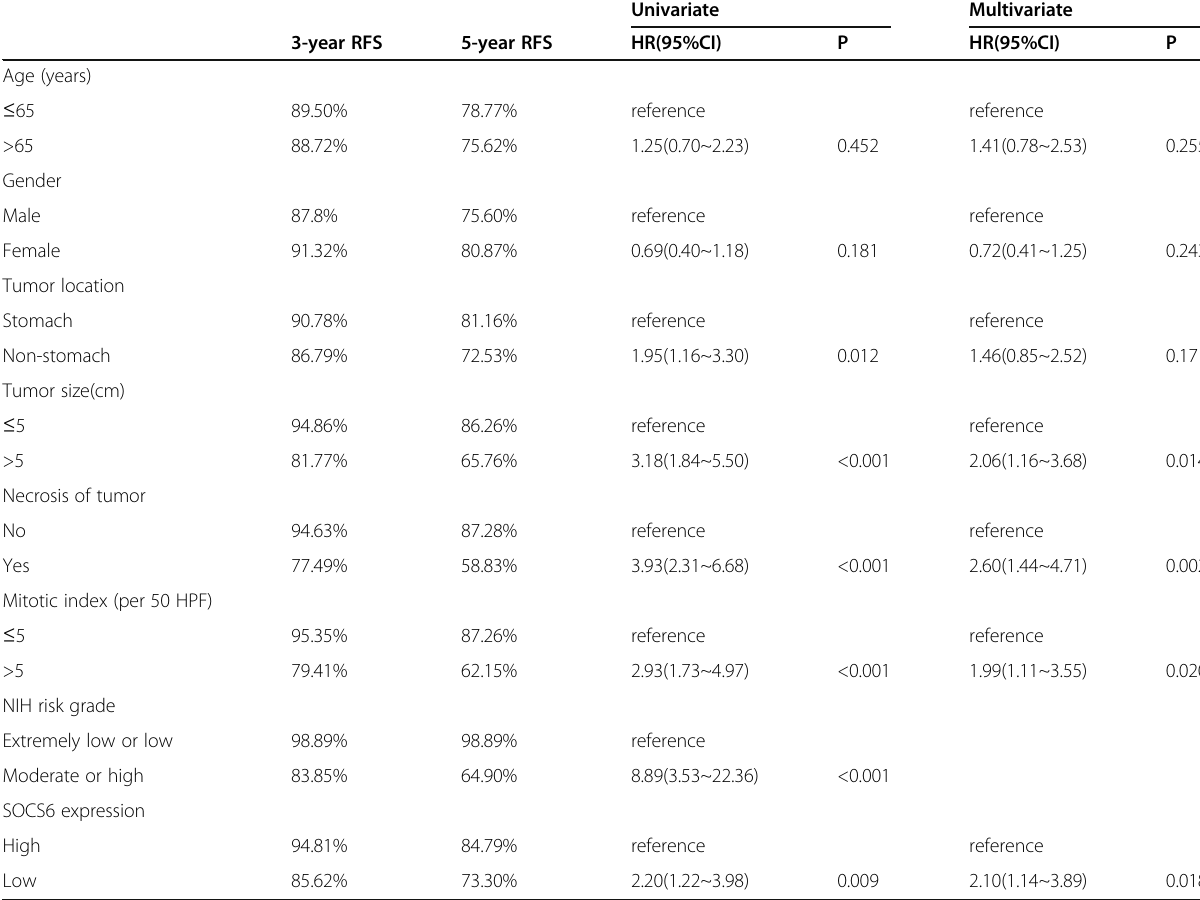
Table 3 Cox proportional-hazard regression model analysis for for recurrence-free